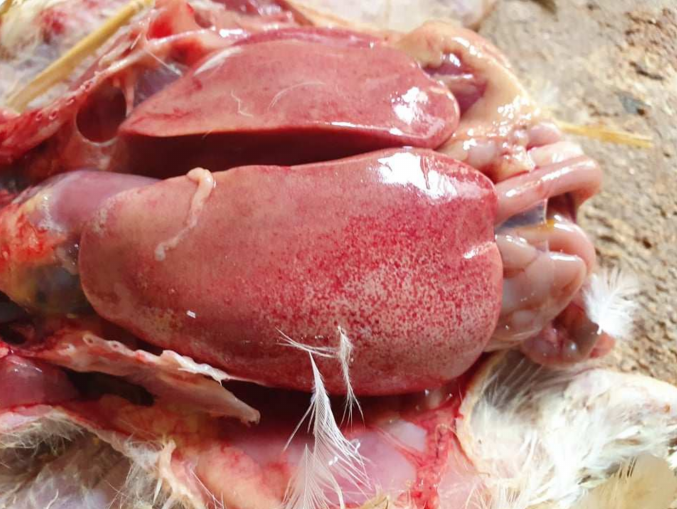
Figure 5. Post-mortem examination of a 23-day-old broiler chicken from the Flock A. The liver dominates in the visceral capacity with the lobes of the organ appearing swollen with a marble-like pattern ranging from pale and yellowish to red-dark.